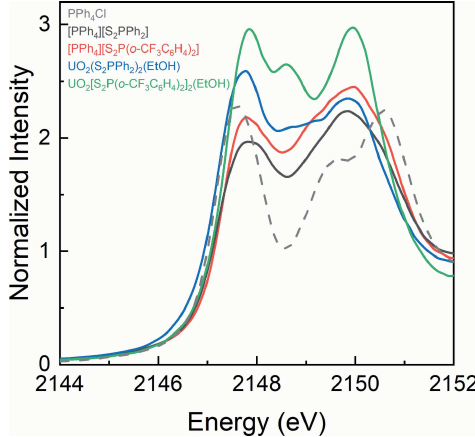
Figure 2 Background-subtracted and normalized P K -edge XAS spectra for PPh 4 Cl, [PPh 4 ][S 2 P R 2 ] and UO 2 (S 2 P R 2 ) 2 (EtOH).